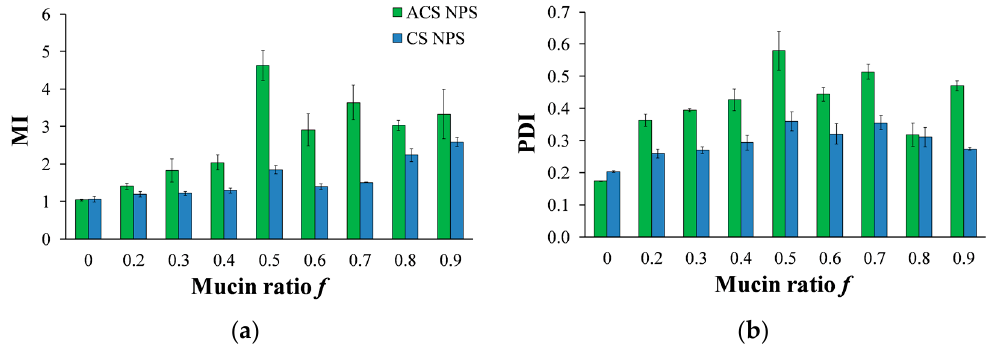
Figure 8. ( a ) MI values calculated for various compositions of mucin-ACS nanoparticle complexes (green) and mucin-CS nanoparticle complexes (blue) as measured by dynamic light scattering (DLS). ( b ) PDI for various compositions of mucin-ACS nanoparticle complexes (green) and mucin-CS nanoparticle complexes (blue) as measured by DLS.